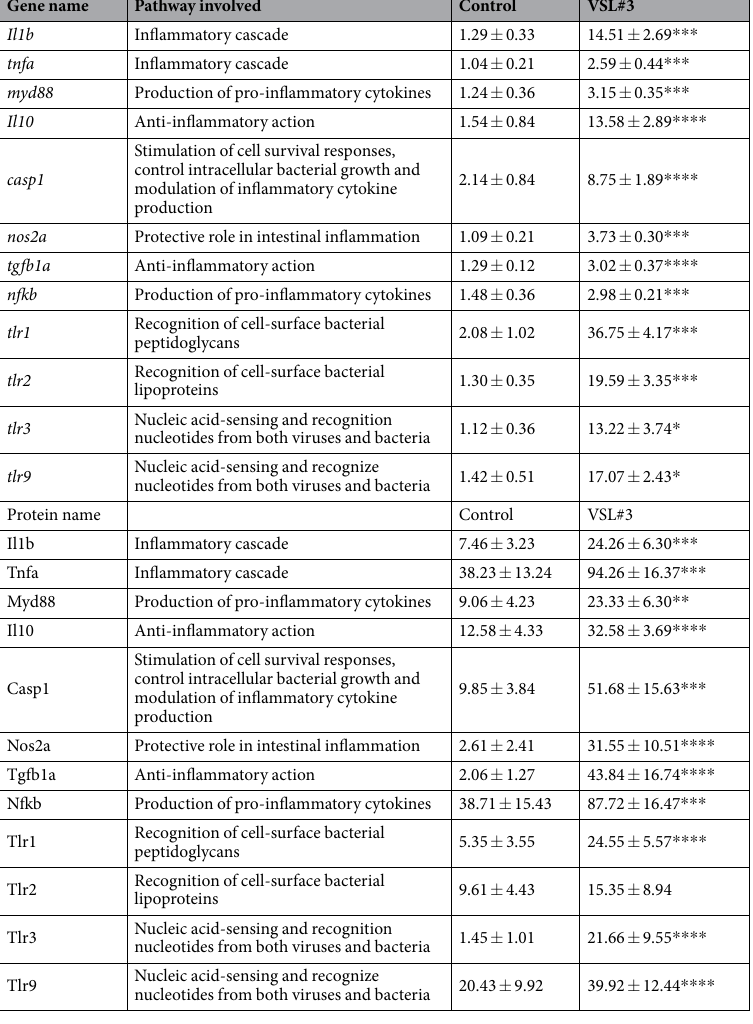
Table 1. (A) Intestinal mRNA levels tested by qPCR and (B) protein levels by IHC of immune system and inflammatory related molecules, in control (CTRL) and VSL#3-treated (VSL#3) 129 fish. Values indicate mean ± SD. * p < 0.5; ** p < 0.01; *** p < 0.001; **** p <